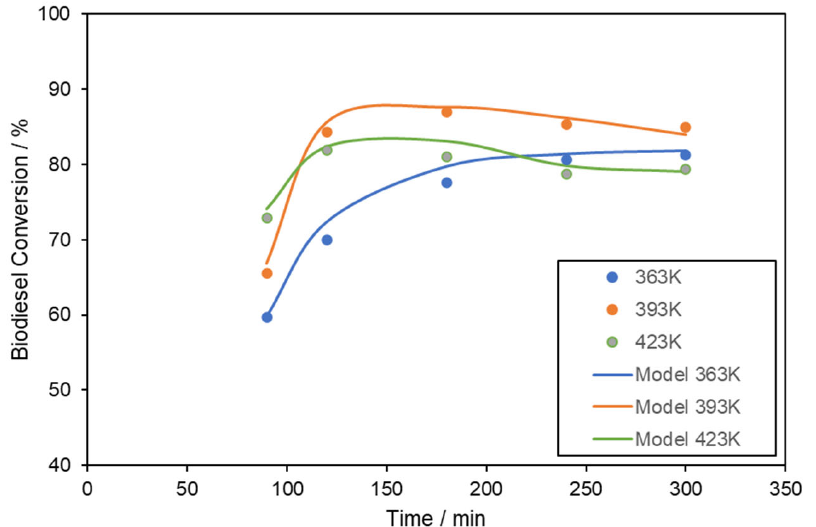
Figure 5. Temperature and reaction time effect on biodiesel conversion at constant methanol-to-oil ratio of 40, using oil derived from Chlorella pyrenoidosa algae. Experimental data were taken from [33].